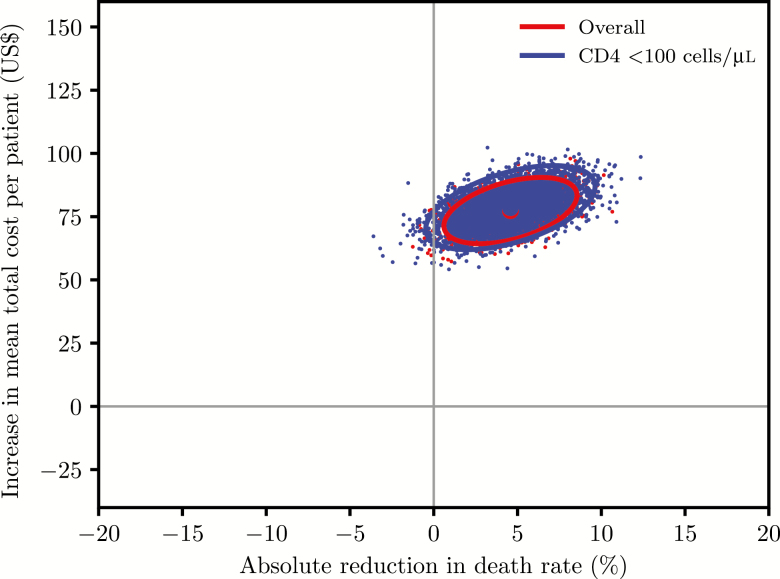
Cost-effectiveness planes after bootstrapping showing uncertainty in the estimated incremental costs and the annual probability of death (%) for persons with CD4 count up to 200 cells/μL (red dots) and among persons with CD4 count < 100 cells/μL (blue dots). Ellipses represent 95% confidence intervals and dots represent estimated incremental costs and death rates.